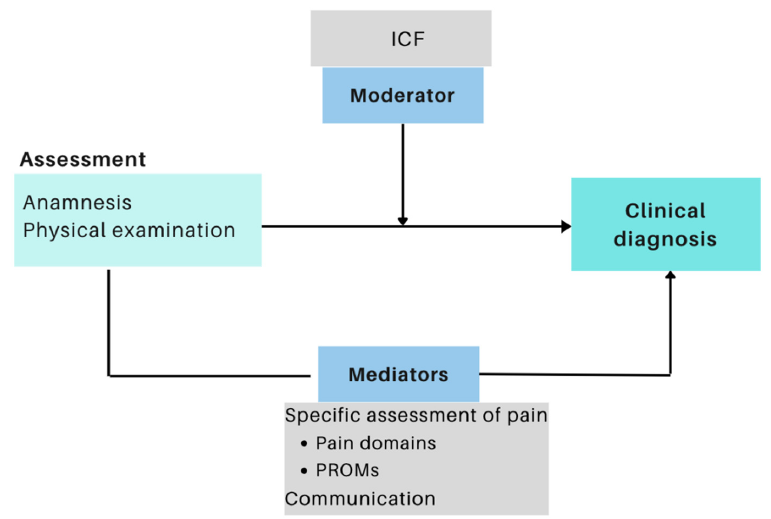
Figure 1. Proposal for a conceptual framework for assessing chronic musculoskeletal pain.